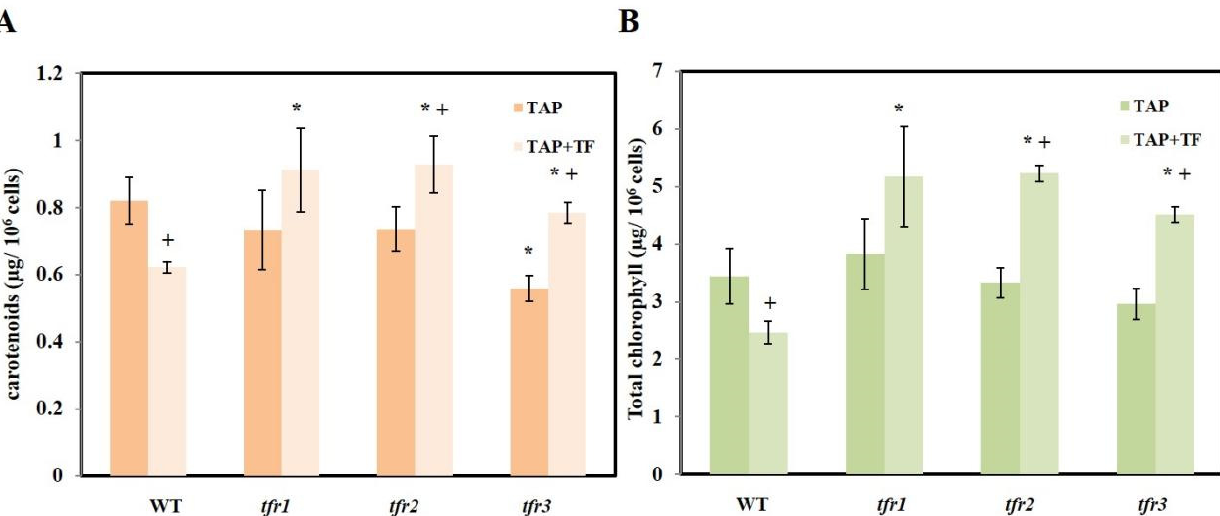
Figure 4. ( A ) Carotenoid and ( B ) chlorophyll content under N-replete medium in the presence and the absence of terbinafine. All data are means ± SD of three biological replicates. Significant differences between the wild type (WT) and the mutants within the same condition are indicated by asterisks (*) ( p < 0.05). Significant differences between different treatments of the same strain are indicated by plus sign (+) ( p < 0.05). The overaccumulation of sterols in Chlamydomonas terbinafine-resistant mutants is in agreement with previous reports in yeast. The yeast Saccharomyces cerevisiae and Schizosac- charomyces pombe terbinafine resistance mutants also exhibited higher ergosterol content